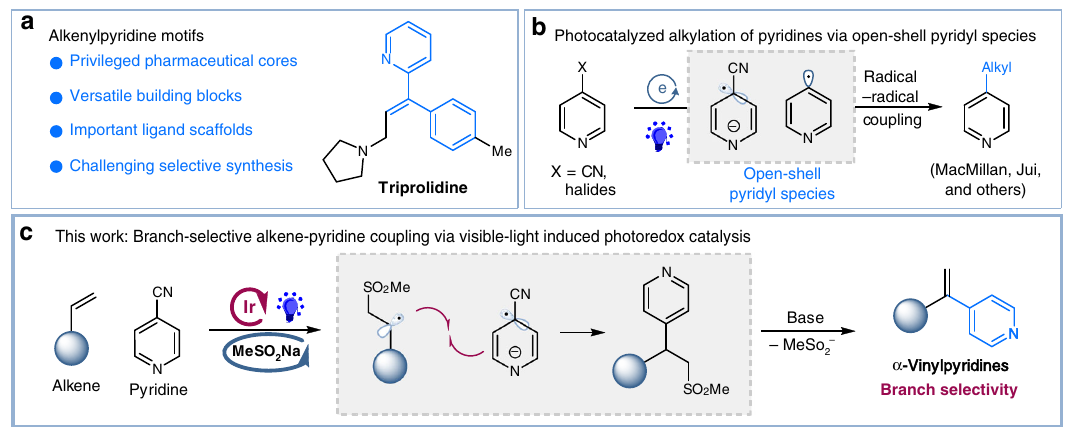
Fig. 1 Design of catalytic and branch-selective alkene – pyridine coupling via photoredox catalysis. a Importance of alkenylpyridines. b Photocatalyzed alkylations of pyridines. c Design of branch-selective alkenylation of pyridines via photoredox